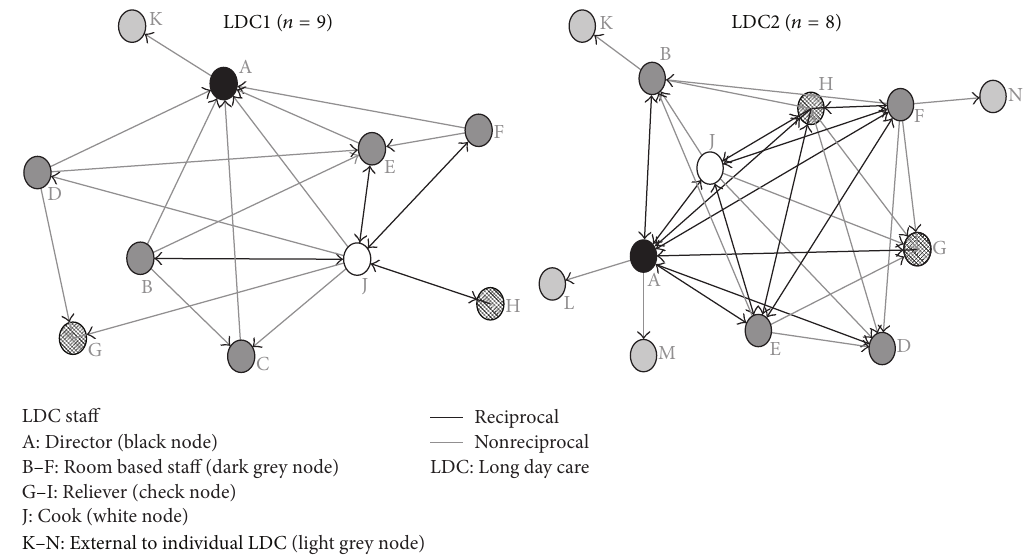
Figure 3: LDC1 and LDC2 dietary information networks.